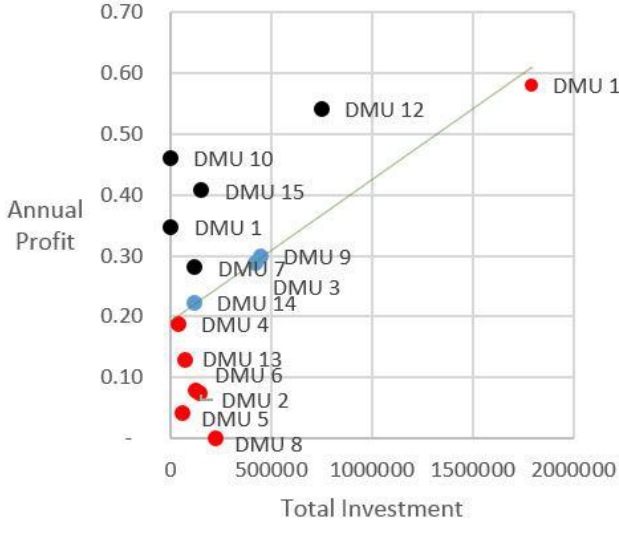
Figure 6. Trend Chart of